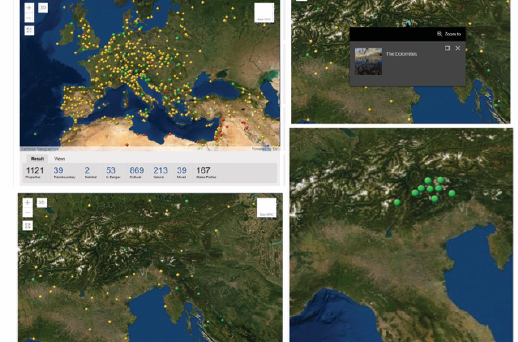
Figure2 WH List detail of the Dolomites properties (from the global location to the local subpoints